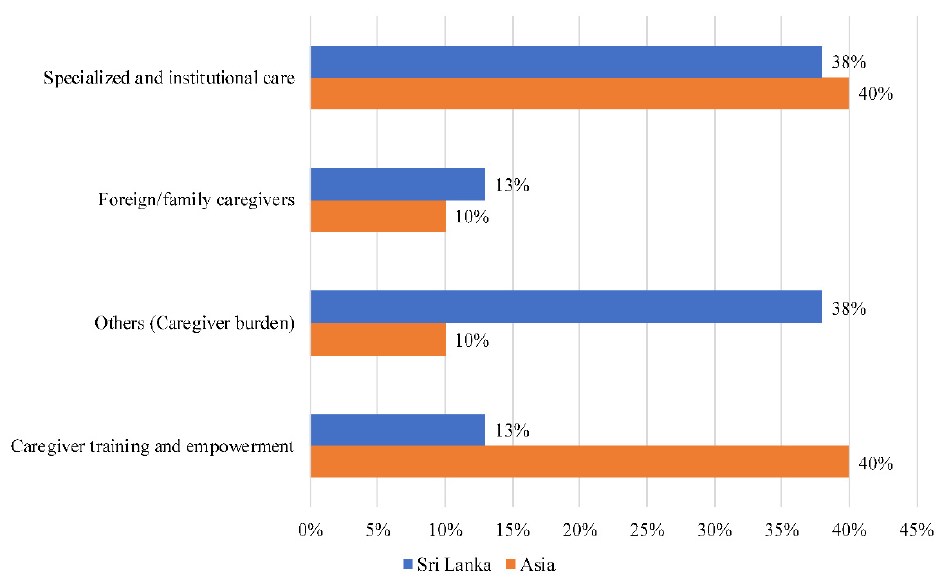
Figure 2. Societal narratives on caregivers in Sri Lanka.